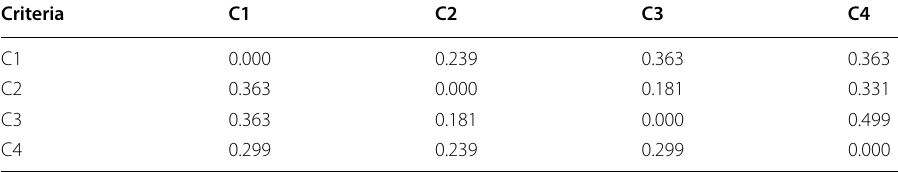
Table 17 Defuzzified relation matrix for the equity-based crowdfunding alternative